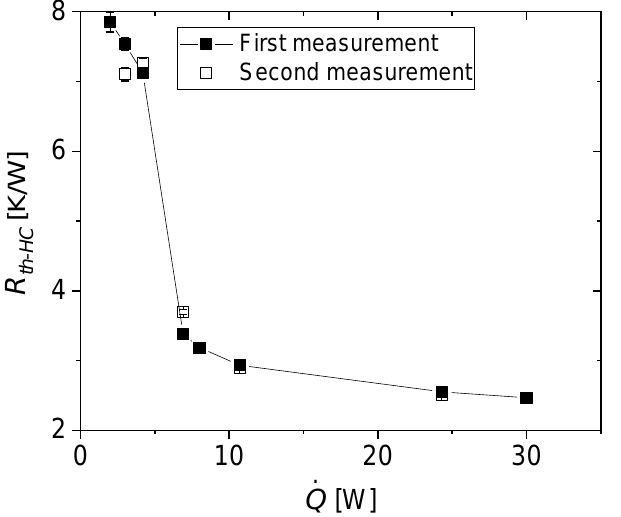
Figure 15. R th − HC versus heating power (full squares). The measurements were repeated to evaluate the reproducibility of the thermal switching effect (empty squares). Lines are given as eye guides.